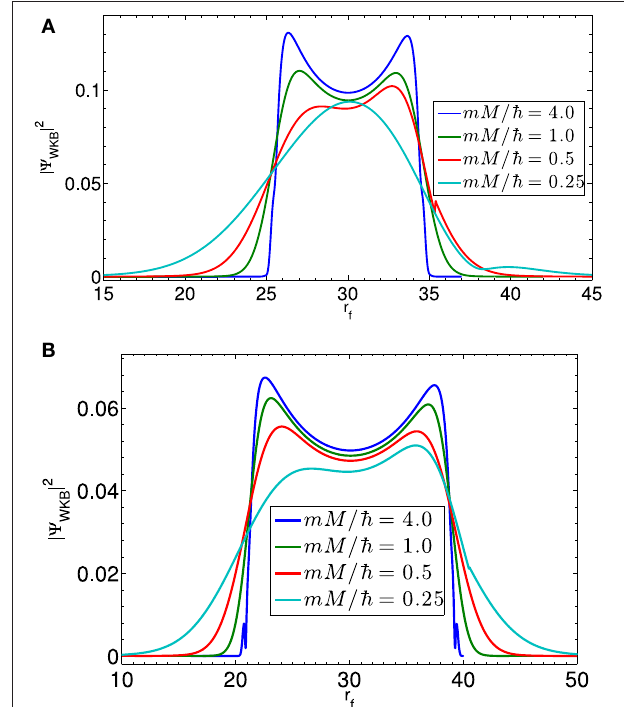
2 at t 9 ( r f , t f ) FIGURE 5 | (A) 5 M as a function of r f for mM / | | = mM / h h h 1, mM / 0.5, and mM / 0.25. It can be seen that that lower = = = ¯ ¯ ¯ masses behave more quantum mechanically, and are less likely to collapse to